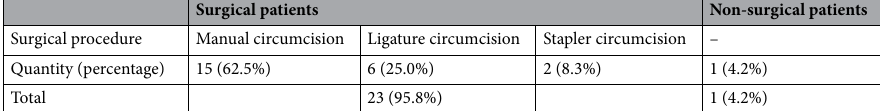
Table 2. Incidence of secondary epidermoid cysts of the penis after surgery and different surgical modalities. The proportion of patients with secondary epidermoid cysts of the penis after circumcision was significantly higher than that in non-circumcised patients. Among the three methods of circumcision, the proportion of secondary epidermoid cysts of the penis after manual circumcision was the highest, which was significantly higher than that of ligation and stapler